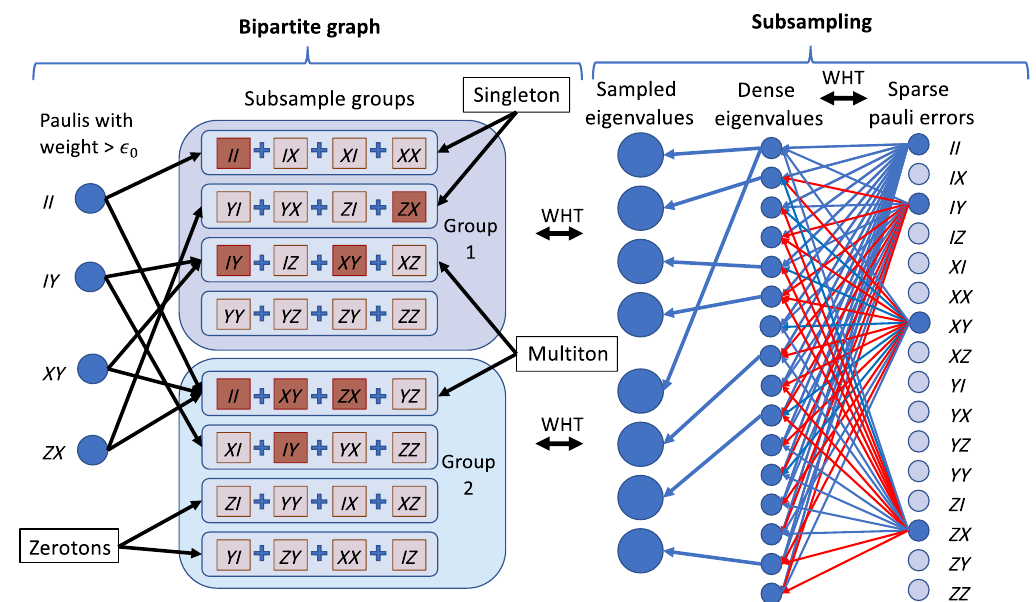
FIG. 2. Illustrative diagram of the bipartite graph that is used to extract information from the subsampling bins. Here we show a simple example for two qubits, where only three nontrivial Paulis ( IY , XY , and ZX ) have errors. To follow the diagram, we have on the right-hand side all 16 possible Pauli errors. The ones with weight > (cid:2) 0 are darker colored. The WHT transform combines these Pauli errors, forming the “dense eigenvalues.” The color of the arrow indicates whether the Pauli is added or subtracted by the transform—although the detail is not necessary to follow here. The subsampling algorithm then selects two sets of stabilizer groups. In this example the first corresponds to the II , IX , XI , and XX stabilizers, the second to the II , ZY , XZ , and YX stabilizers. These form the two sets of sampled eigenvalues . Each of these two groups of four sampled eigenvalues can then be transformed back using a WHT transform yielding four numbers for each group. Each of these four numbers is made up of the sum of four possible Pauli errors, which are indicated inside the inner boxes. For ease of reference the Paulis with weight greater then (cid:2) 0 are colored red. This is shown in the right-hand side of the “bipartite graph” section of the diagram. To summarize, at this stage, the subsampling algorithm has split the Paulis up as shown ( II , IX , XI , and XX stabilizers for group 1 and II , ZY , XZ , and YX for group 2), separating them into bins consisting of singletons, multitons, and zerotons, as described in the text. In this example, it can be seen that the IY Pauli exists as a singleton in group 2, allowing its value to be recovered. It can then be “peeled” from the third bin in group 1 converting that bin from a multiton to a singleton containing just Pauli XY . This then allows Pauli XY to be recovered as well, which would not otherwise be possible, as the signal would conflate with that of IY (if one were looking at group 1 in isolation). Iterative peeling in this fashion will eventually recover all of the nonzero Pauli error rates. Details as to how we determine if a bit is a singleton or multiton are contained in the text. Workbooks in [42] contain example